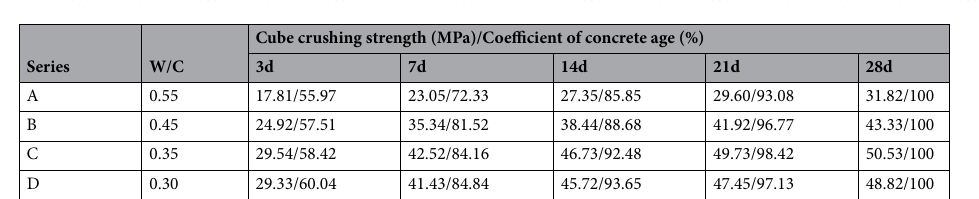
Figure 6. Crack development under failure.